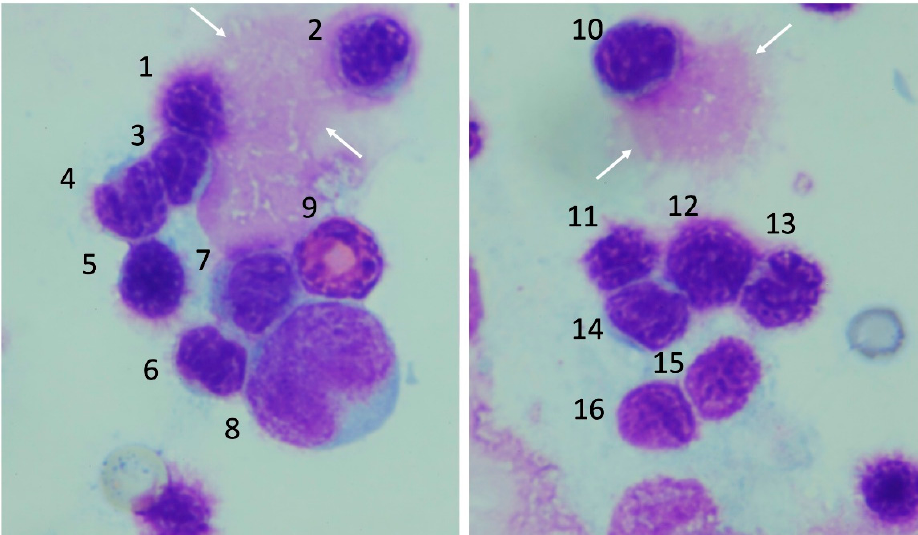
Figure 5. Bone marrow smear in the lethal model of heatstroke. Severe cellular damage was recognized in the bone marrow smear obtained from severe heatstroke group. Burst nuclei are indicated by the white arrows. 1: damaged erythroblast, 2–4 damaged lymphocytes, 5: damaged erythroblast, 6, 7: damaged lymphocytes, 8: promonocyte, 9: eosinophilic band cell, 10: burst lymphocyte, 11–13 damaged erythroblasts, 14–16: lymphocytes.